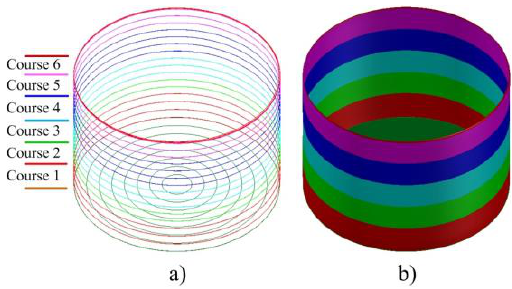
Table 1 . Geometric information of courses of a shell wall